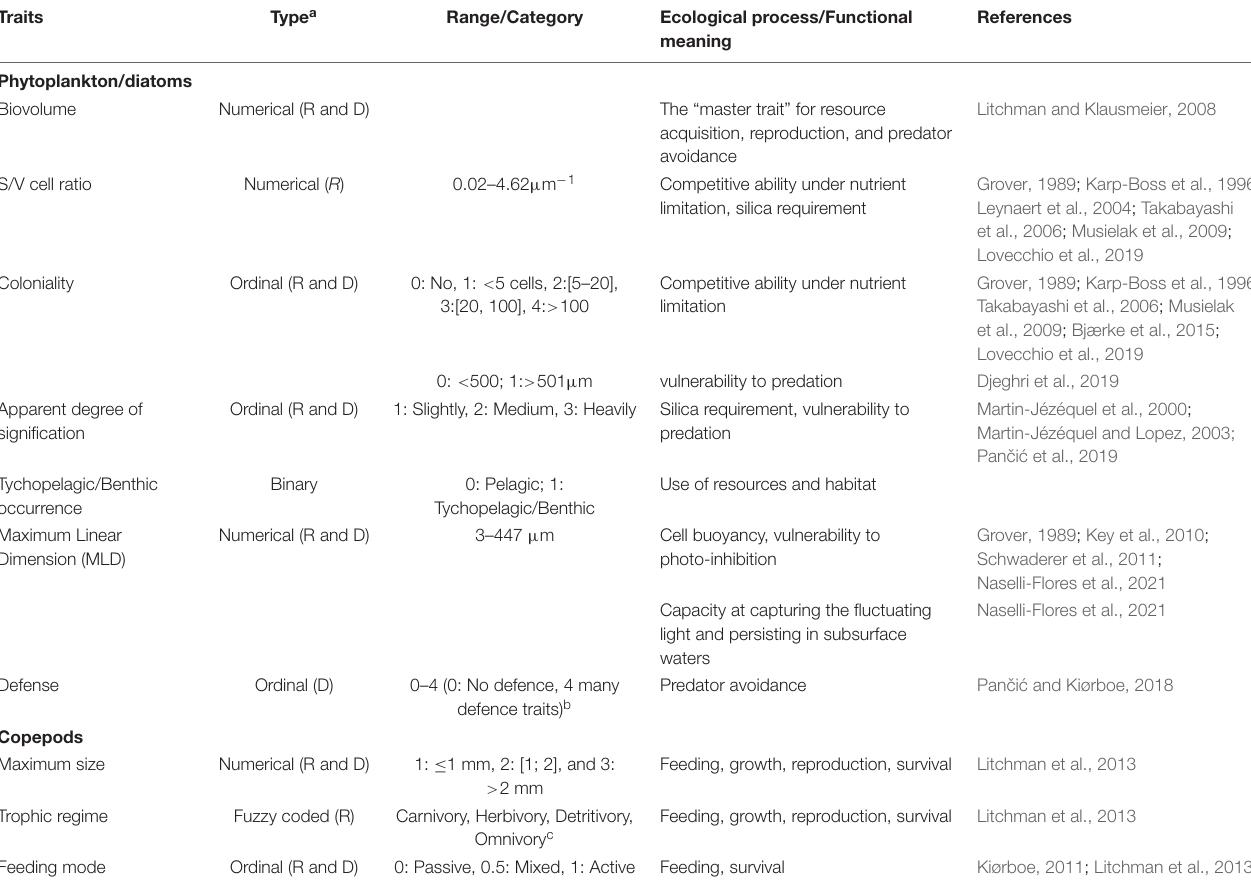
TABLE 1 | List of the diatom and copepod traits used in this study and their functional